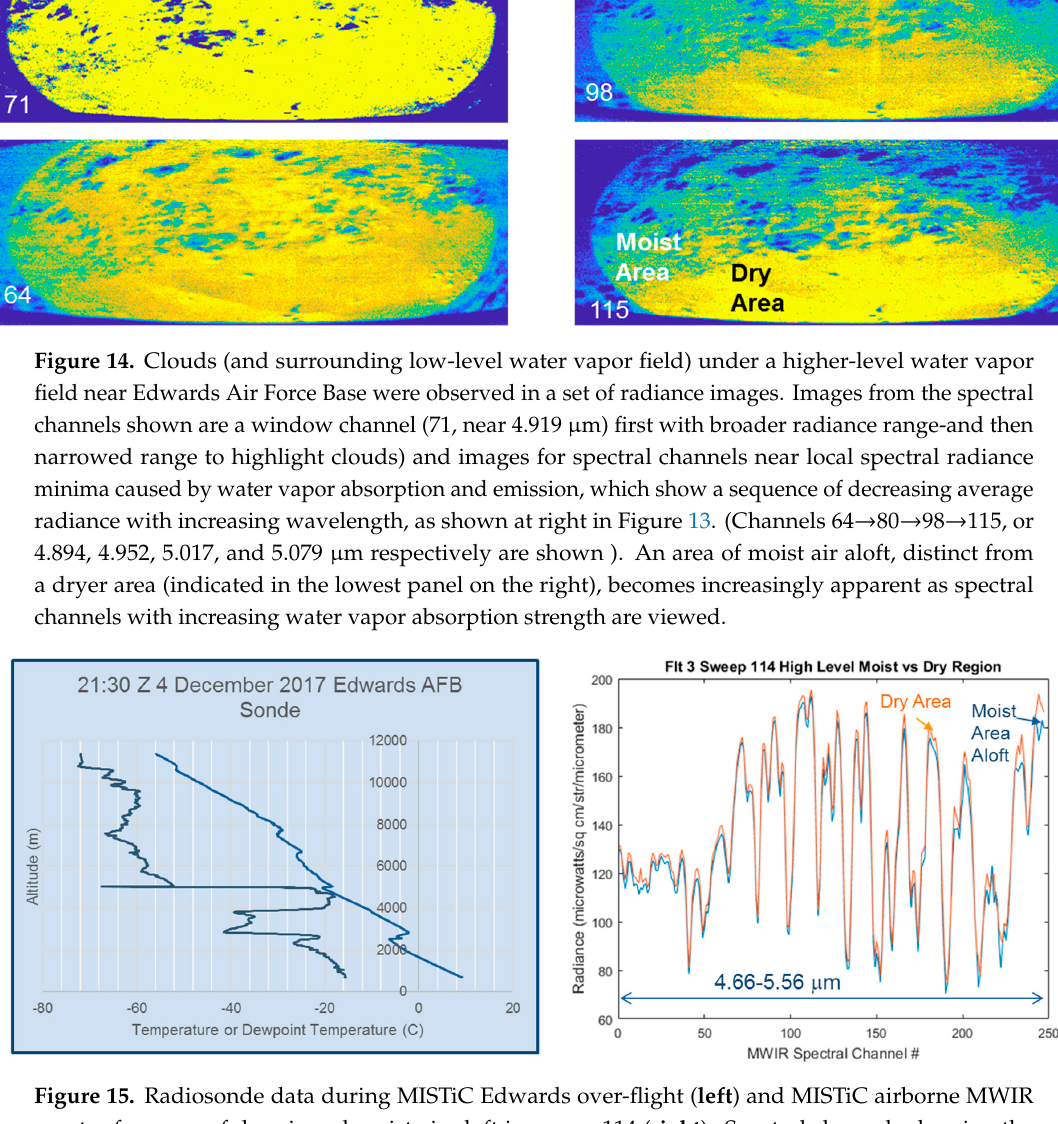
Figure 15. Radiosonde data during MISTiC Edwards over-flight ( left ) and MISTiC airborne MWIR spectra for areas of dry air and moist air aloft in sweep 114 ( right ). Spectral channels showing the greatest differences between dry and moist areas in Figure 14 are in the longer wavelength portions of the band that are most sensitive to higher-level water vapor. This is consistent with the high dew-point temperature layer aloft shown in the radiosonde data.